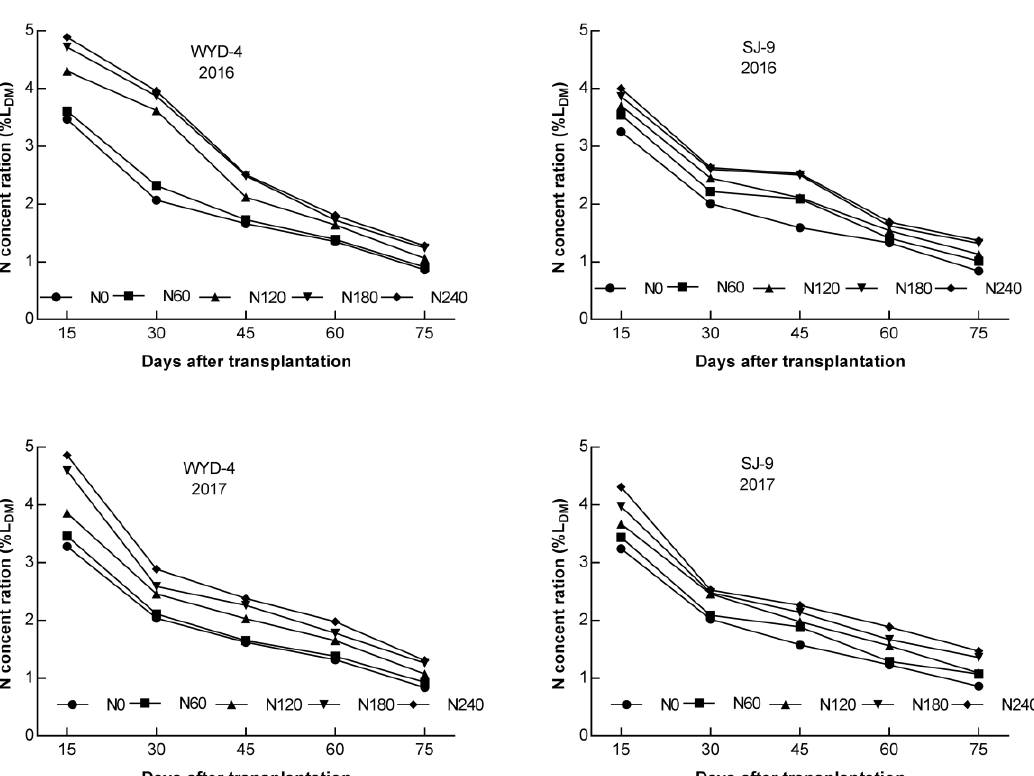
Figure 3. Changes of nitrogen (N) concentration (%L DM ) with time (days after transplantation) for rice under different N application rates in experiments conducted during 2016 and 2017.